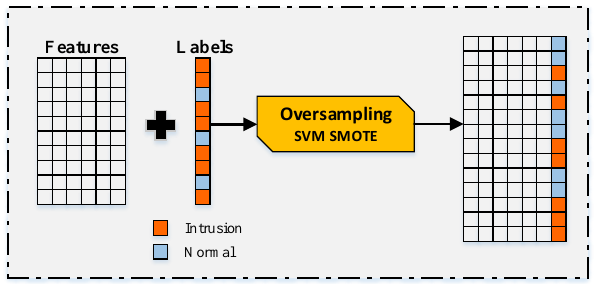
Figure 5. The SVM-SMOTE oversampling technique to increase the number of instances of the normal